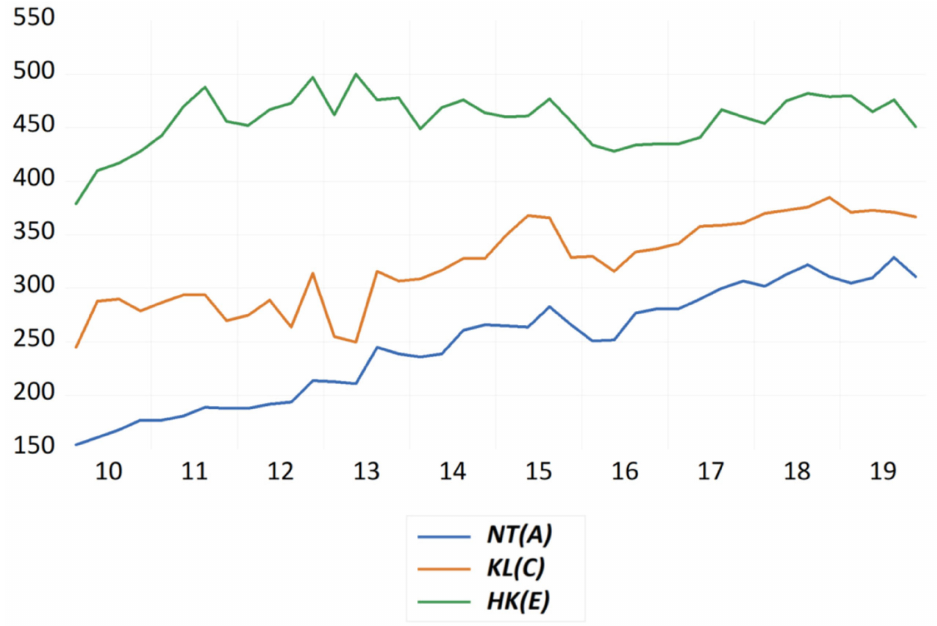
Figure 2. Average rent per m 2 of the three sample